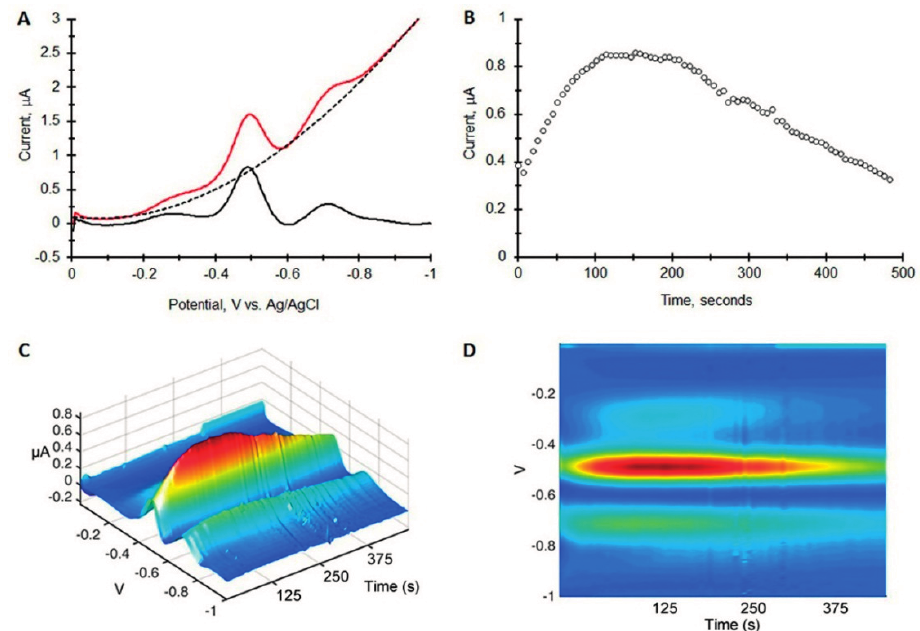
Figure 2. Square wave chromato-voltammogram of 1 µg of TNT on a paper-based electrochemical probe with its edge placed in 200 µL of an ethylene glycol/choline chloride 2:1 molar mixture. Square wave parameters are amplitude = 25 mV, frequency = 60 Hz. ( A ) A square wave voltammogram at the peak maximum in time showing the polynomial background subtraction (dotted line); ( B ) Current measured at I pc vs. scan number; ( C , D ) 3 dimensional representations of the same square wave chromato-voltammogram.